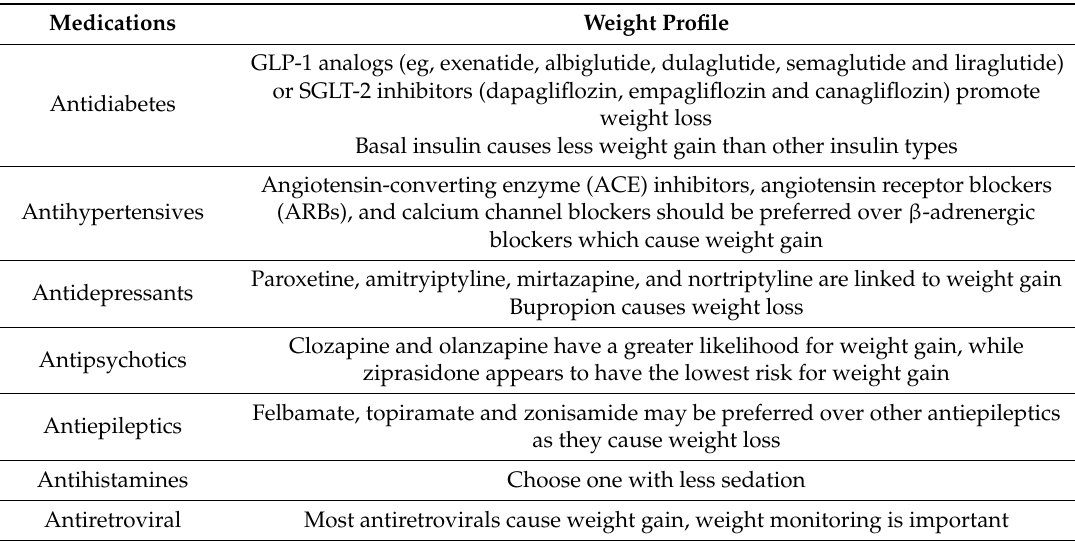
Table 7. Medications prescribed and their treatment profile